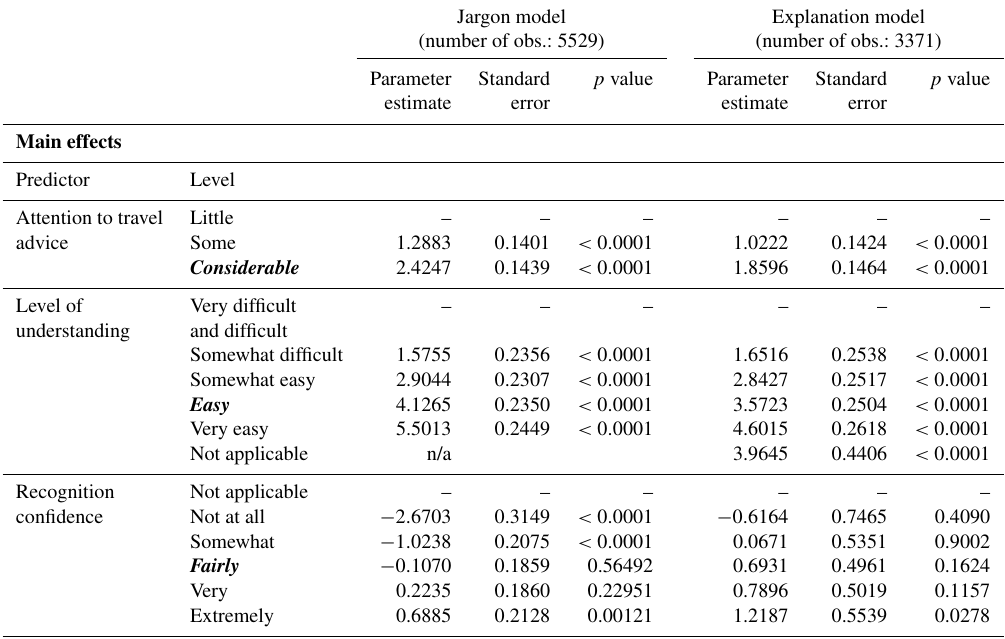
Table B2. Parameter estimates of the jargon and explanation models examining participants’ usefulness ratings for the TTA statements. Bolded and italicized levels are used for calculating the estimated marginal probabilities in the post hoc